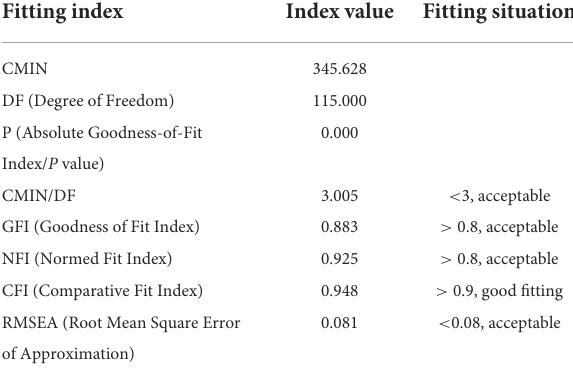
TABLE 15 Simulation fitting results of structural validity.